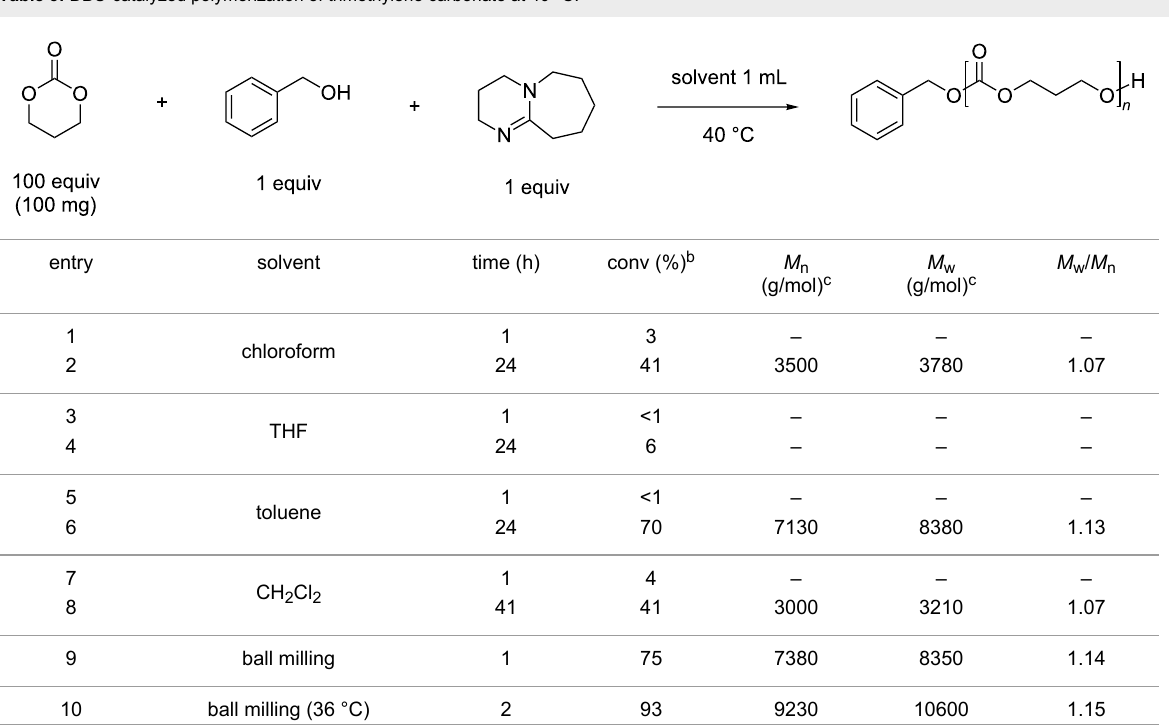
Table 3: DBU-catalyzed polymerization of trimethylene carbonate at 40 °C. a